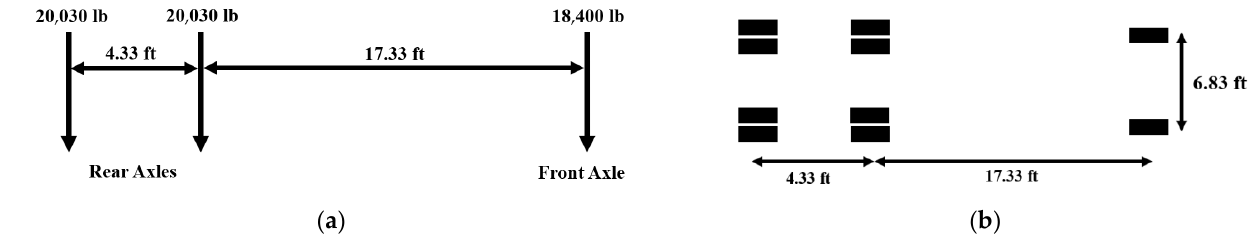
Figure 6. Details of the configuration and dimension of the test truck. ( a ) Side view; ( b ) top view.